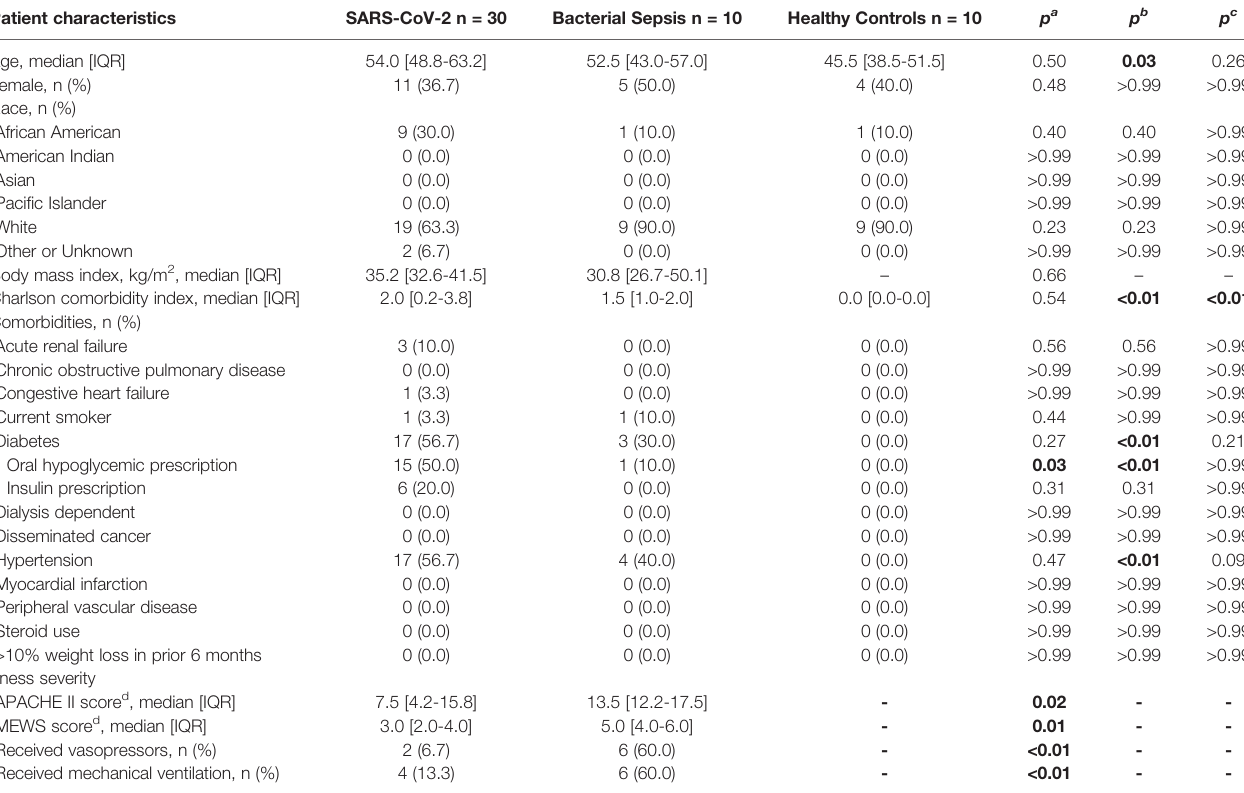
TABLE 1 | Characteristics of SARS-CoV-2, bacterial sepsis, and healthy control cohorts. Patient characteristics